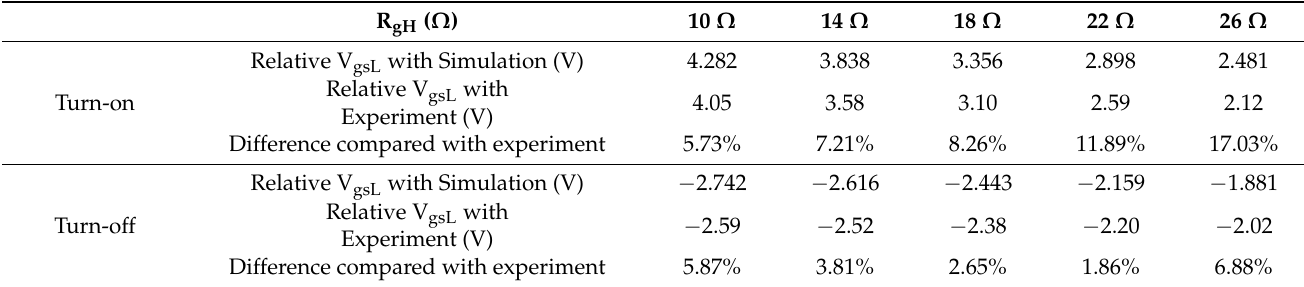
Table 5. Comparison of Experiments and Simulations with Variable R gH .